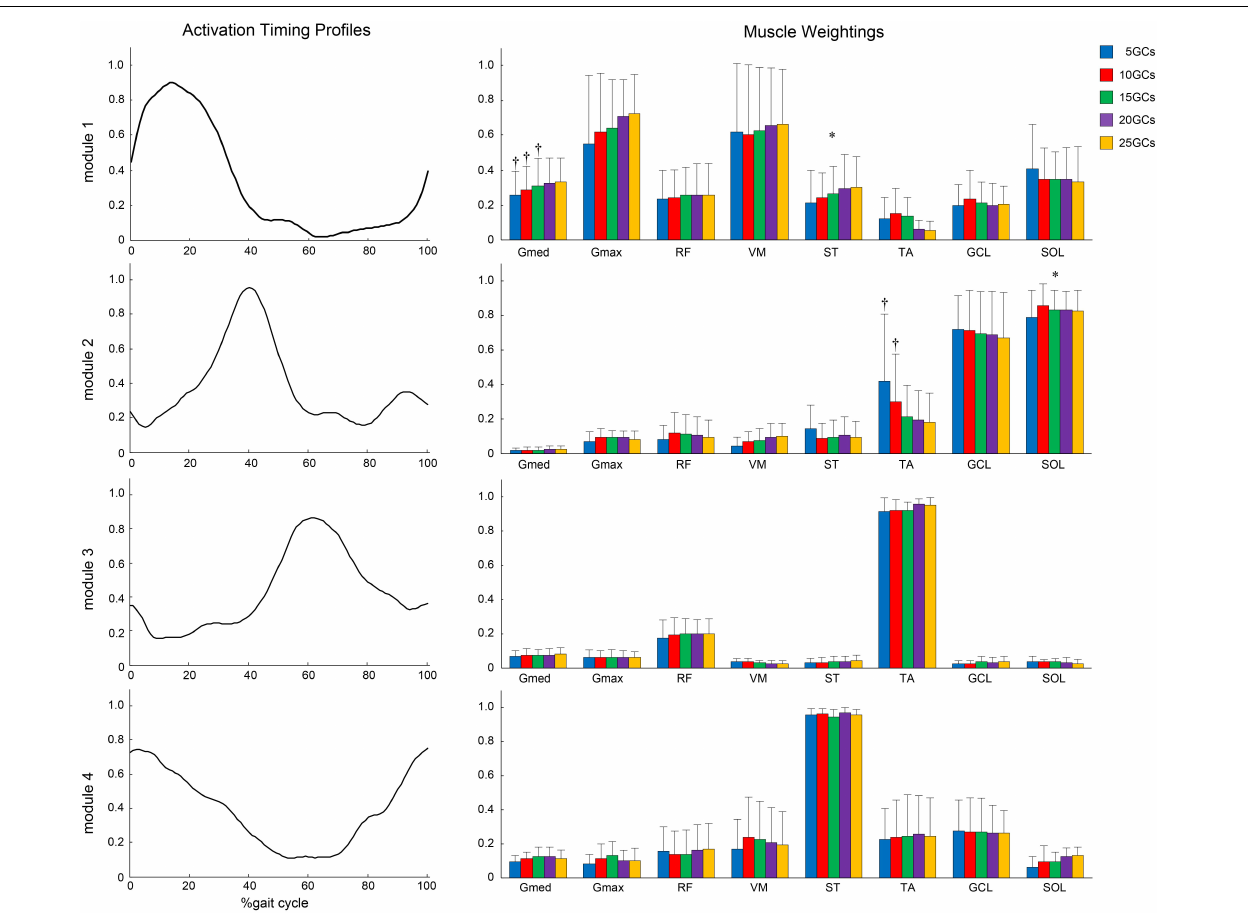
FIGURE 7 | Same activation timing profiles among different GCs and muscle weightings. The effects of the different GCs when the LPF was 4 Hz. Activation timing profiles are shown as the conditional mean. The bars of muscle weightings indicate the conditional median, and the error bars indicate the median absolute deviations. Significant differences are marked with ∗ ( p < 0.05 in the Friedman test only) and † ( p < 0.05 in the Friedman test, and p < 0.0125 when comparing the reference condition, 25 GCs in the Bonferroni-corrected Wilcoxon signed-rank sum test). LPF, low-pass filter; GC, gait